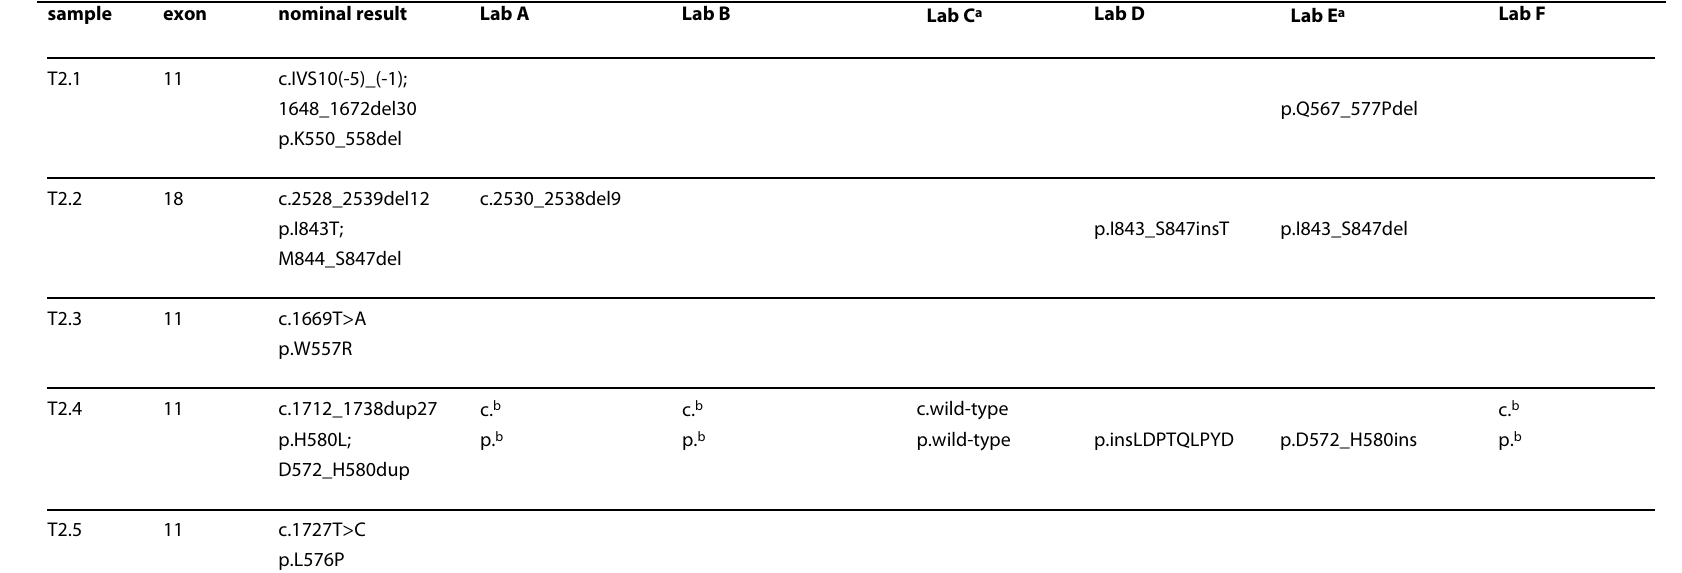
Table 2: Nominal and actual results of the mutation analyses of KIT exons 9 and 11 and PDGFRA exon 18 performed in trial 2. sample exon nominal